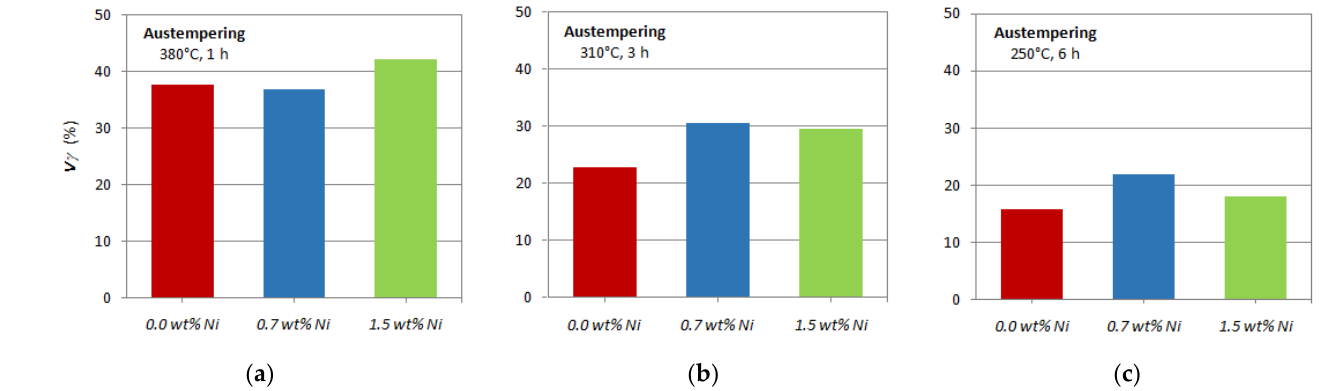
Figure 19. Volume fractions of austenite V γ in 25 mm Y-block ADIs for different Ni contents and different austempering conditions: ( a ) 380 °C for 1 h; ( b ) 310 for 3 h; ( c ) 250 °C for 6 h.